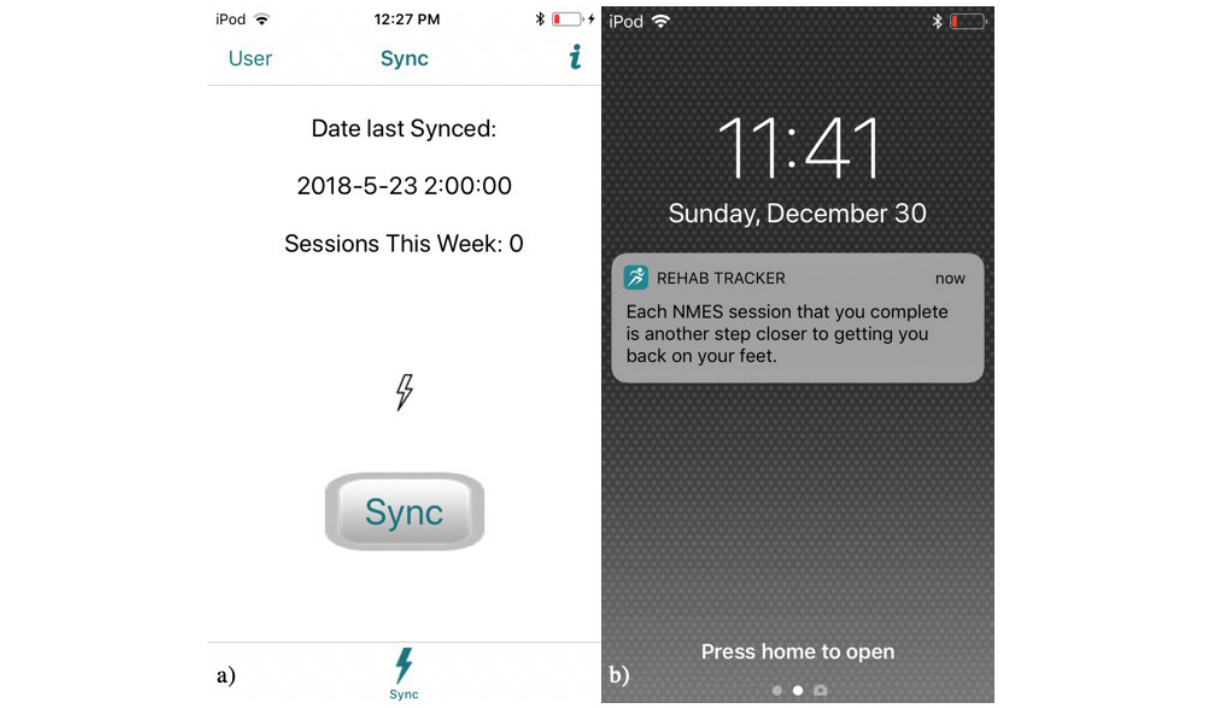
Figure 3. Sample screenshots from the RehabTracker mobile health app, which includes functionality to sync session data with the secure database (shown in screenshot “a”) and encourages patients’adherence to the push notifications (shown in screenshot